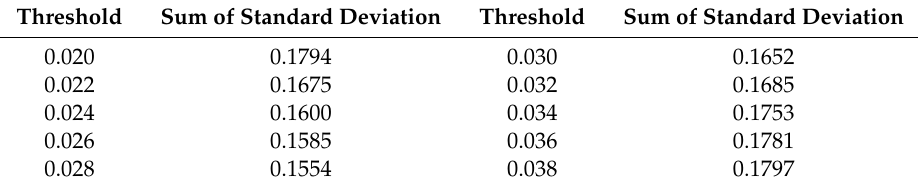
Figure 9. Distinction of pulse count feature with different thresholds. Table 1. Sum of the standard deviation of the pulse count feature with different thresholds.